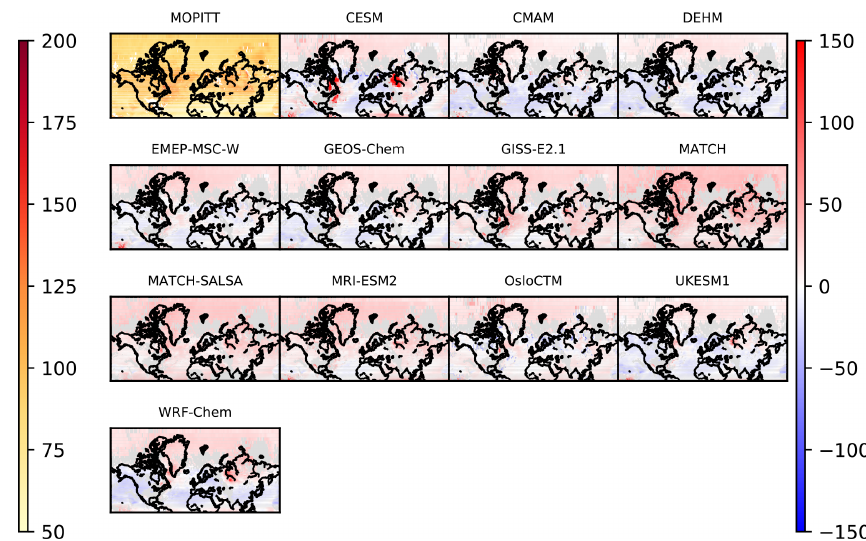
Figure 12. Summertime (JJA) (top left) mean MOPITT CO at 600hPa (ppbv, left color bar) and (remaining panels) model biases (model minus measurement ppbv, right color bar) for 2014–2015.